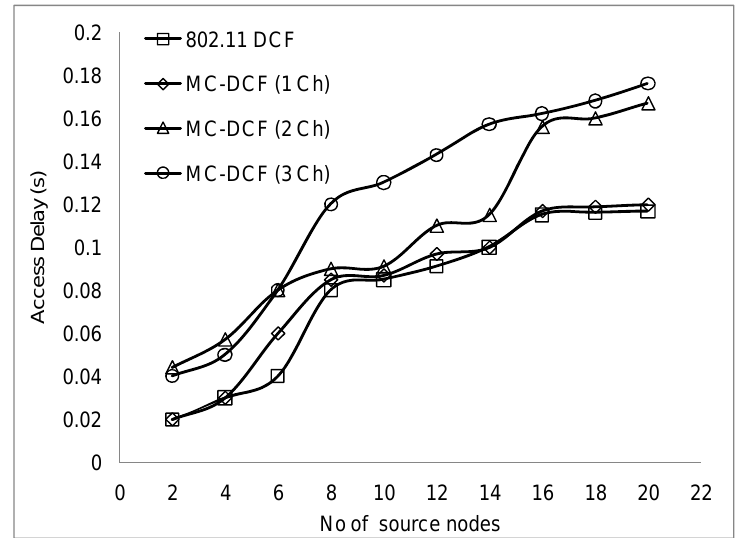
Figure 16. Delay at sink receiving data from source nodes.